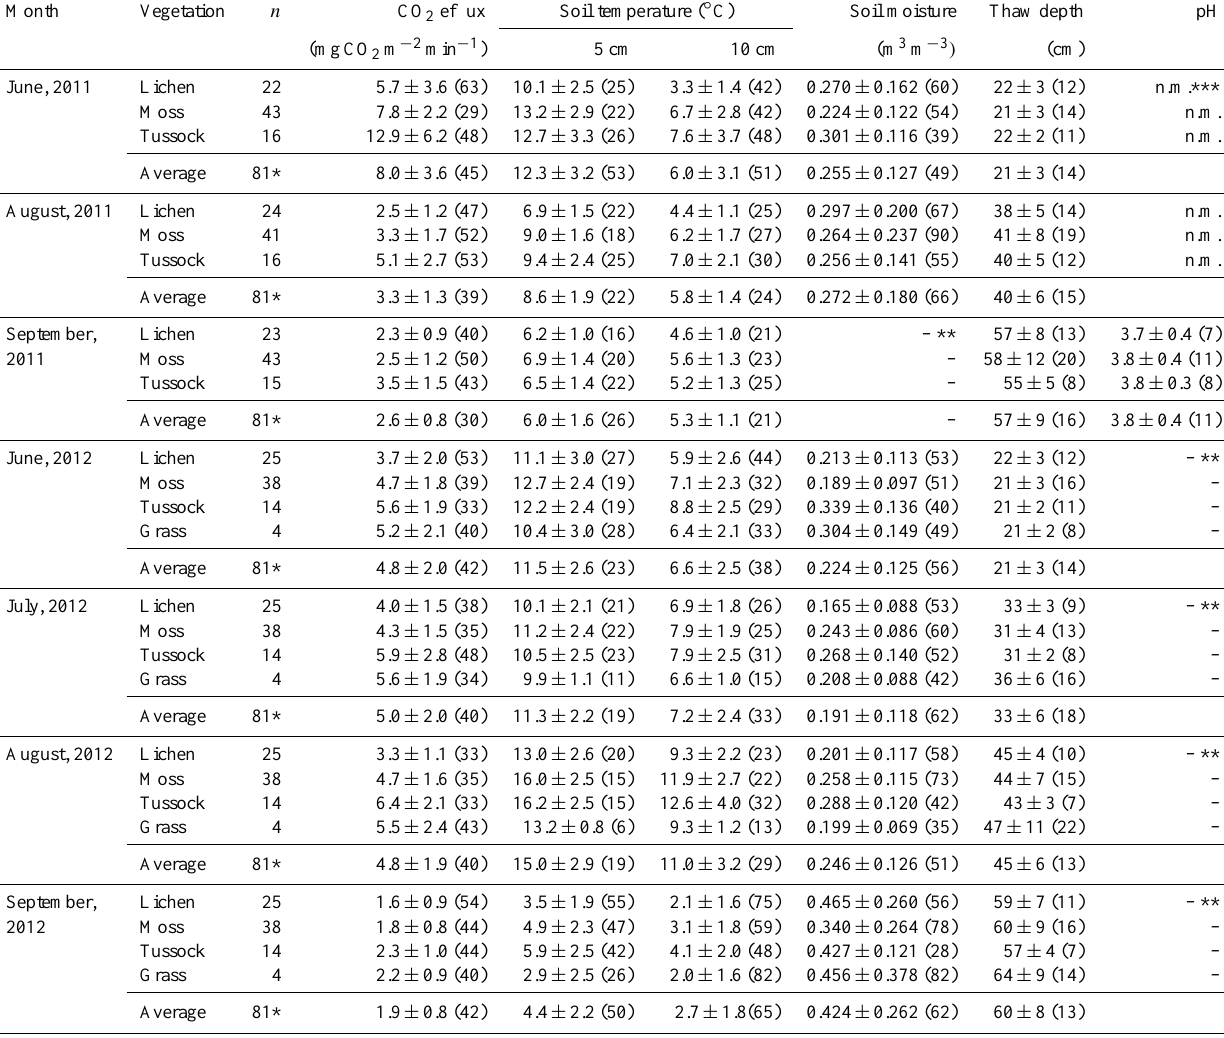
Table 1. Average and standard deviation (coefficient of variation, %) of CO 2 efflux, soil temperature at 5 and 10cm below the surface, soil moisture, thaw depth, and pH in lichen, moss, and tussock tundra in Council, Seward Peninsula, Alaska during growing seasons of 2011 and